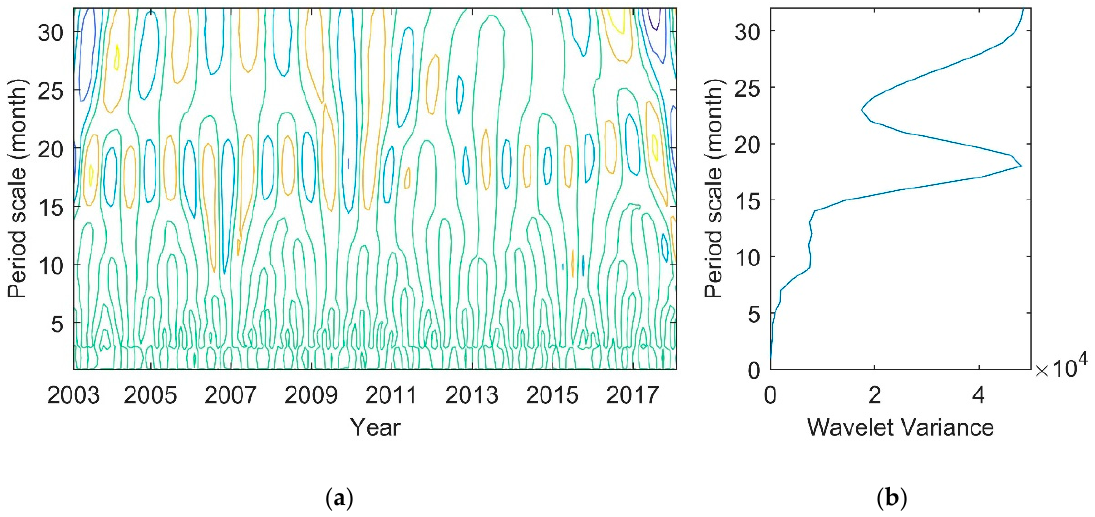
Figure 14. Wavelet analysis of water volume change in Lake Victoria: ( a ) contour map of the wavelet coefficient real part; ( b ) the curve of wavelet variance.